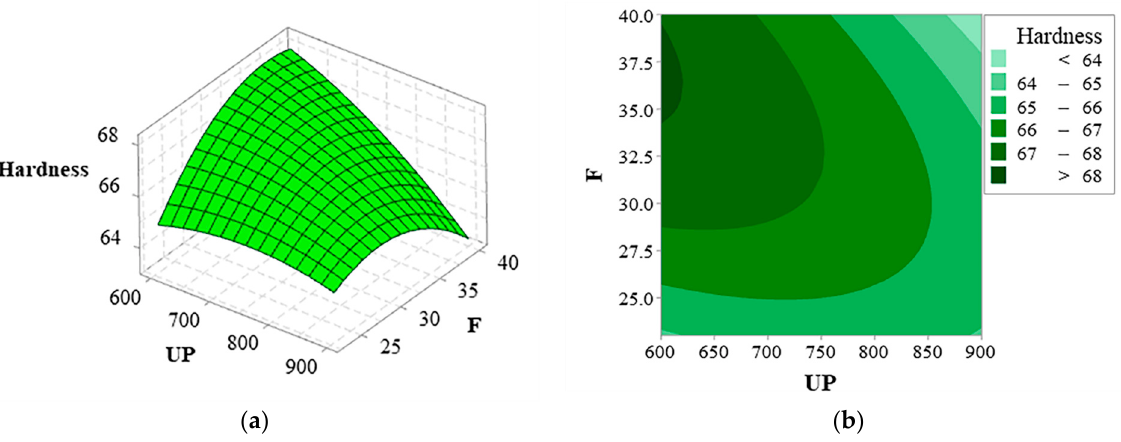
Figure 12. Interaction diagram of UP and F: ( a ) surface diagram and ( b ) contour diagram.